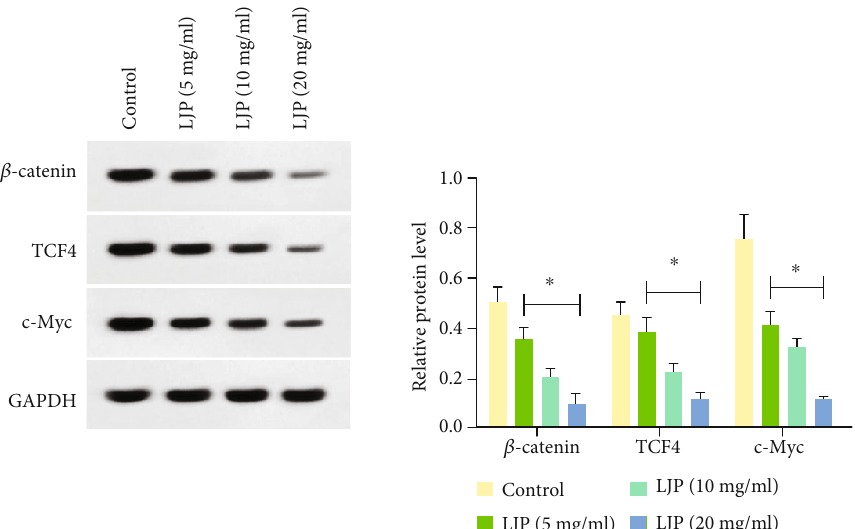
Figure 7: Expressions of signaling pathway proteins in A549 cells. ∗ P < 0 : 05 versus control group. Western blot was used to detect expressions of pathway-related proteins after treated with di ff erent concentrations of LJP for